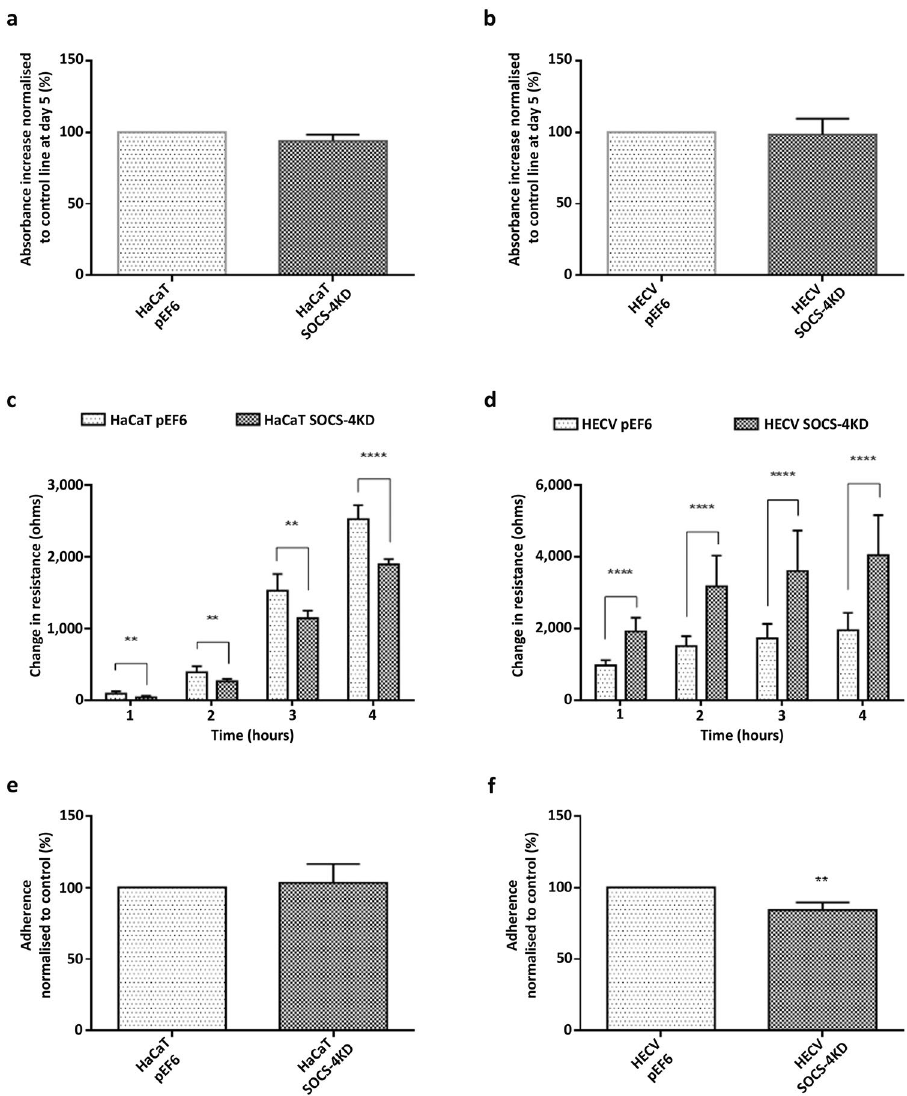
Figure 2. Impact of SOCS-4 knockdown on cell proliferation and attachment. Five day proliferation rates of ( a ) HaCaT and ( b ) HECV cells following SOCS-4 knockdown, percentage respective pEF6 control of at least three independent repeats are shown, error bars represent the standard error of the mean. Cell attachment was assessed using an ECIS based method over 4 hours post seeding in ( c ) HaCaT and ( d ) HECV. Data, representative of at least three independent repeats shows mean change in resistance as detected by the ECIS system and was used to indicate cell attachment to the electrode, error bars represent standard deviation. A Matrigel matrix adhesion assay was also implemented to examine Matrigel attachment of ( e ) HaCaT and ( f ) HECV cells following SOCS-4 knockdown, mean percentage respective pEF6 control of at least three independent repeats are shown and error bars represent the standard error of the mean. ** represents p < 0.01, *** represents p < 0.001 and **** represents p <